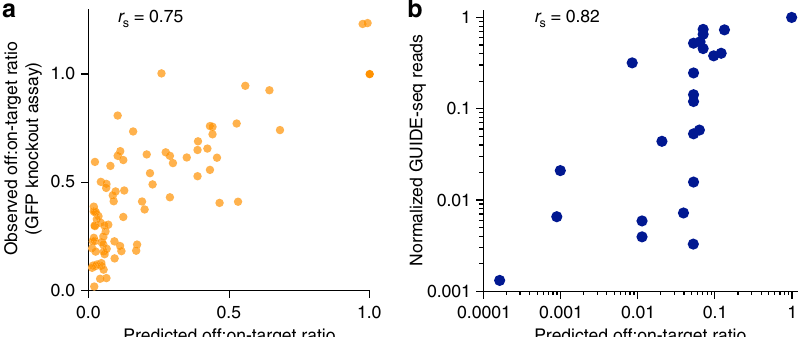
Fig. 3 SaCas9 speci fi city model ranks synthetic and endogenous off-target sites. a A regression model trained on the pairwise library screen data correlates with an independent validation set ( n = 86 guide-target pairs). The sgRNAs knock out a stable GFP and include single mismatches in the spacers to mimic off-target effects. b Spearman rank correlation of the SaCas9 speci fi city model compared with previously reported SaCas9 GUIDE-seq data from a different cell type, U2OS 7